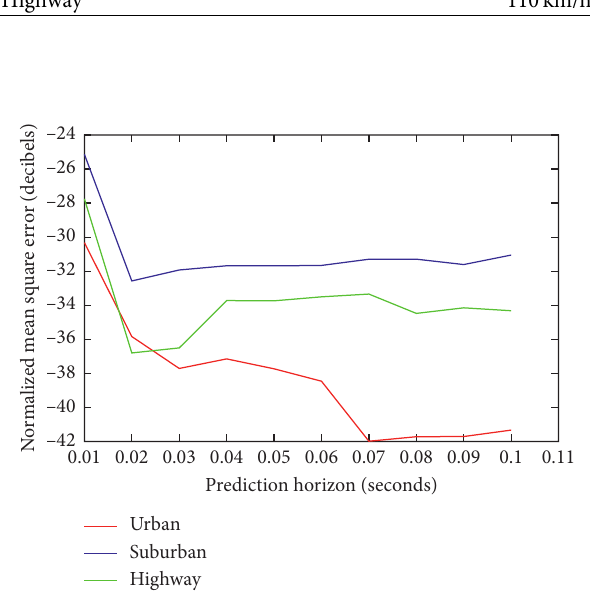
Figure 8: NMSE vs. prediction horizon for different urban, sub- urban, and highway environments with k � 8, L � 100, and Δ t � 1ms.